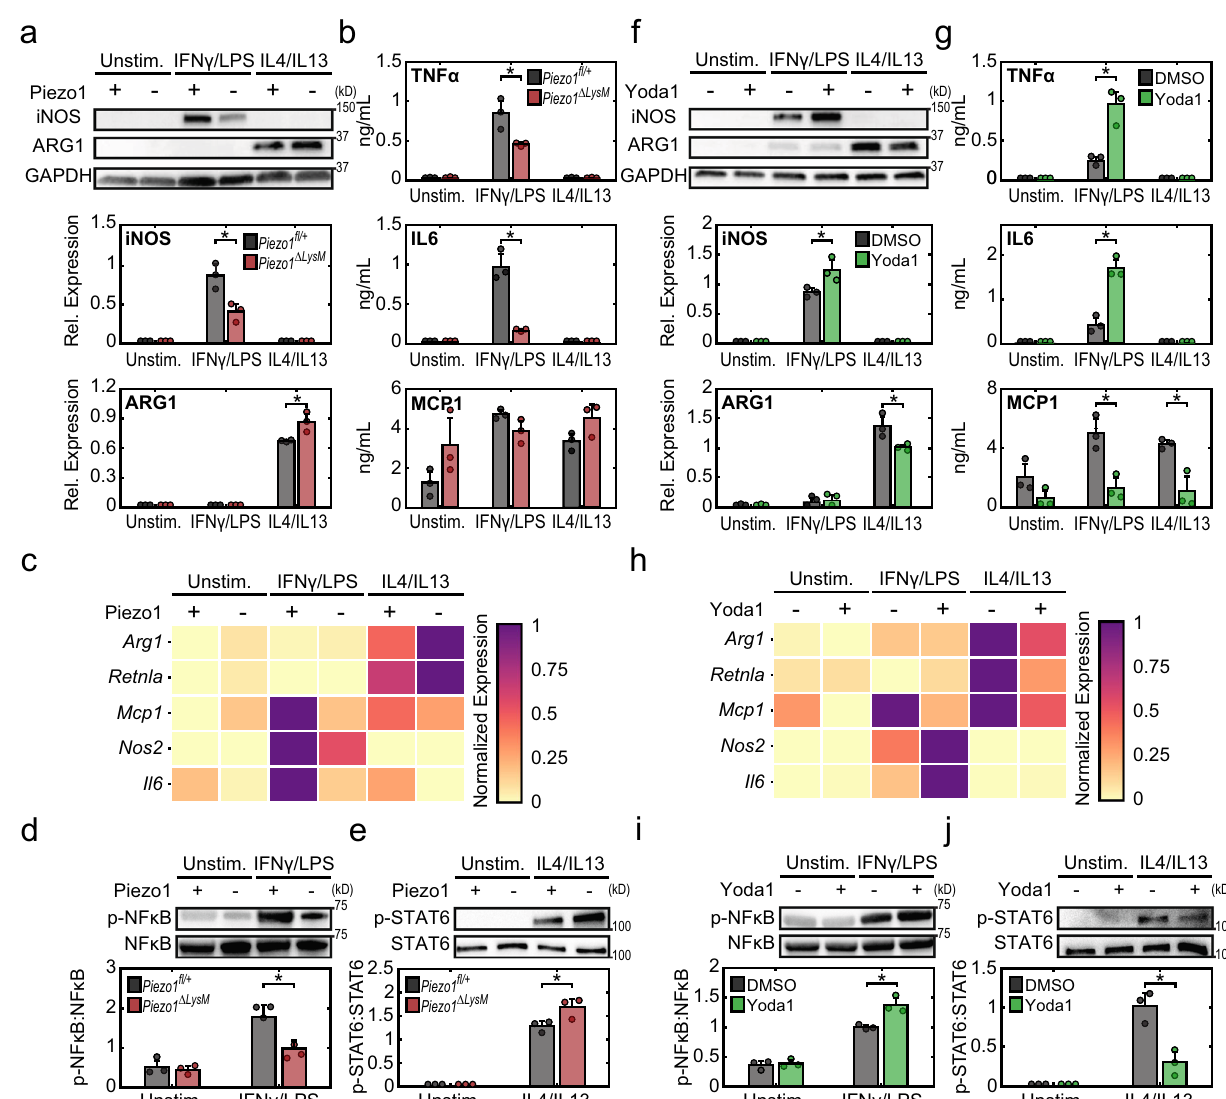
Fig. 1 Piezo1 regulates cytokine-induced macrophage activation. a Representative Western blots (top) and quanti fi cation (bottom) of iNOS, ARG1, and GAPDH of Piezo1 fl / + and Piezo1 Δ LysM BMDMs incubated with media (Unstim.), IFN γ /LPS (0.3 ng/mL of each), or IL4/IL13 (0.1 ng/mL of each). b TNF α , IL6, and MCP1 secretion from Piezo1 fl / + and Piezo1 Δ LysM BMDMs incubated with the indicated conditions, as measured by ELISA. c Relative gene expression